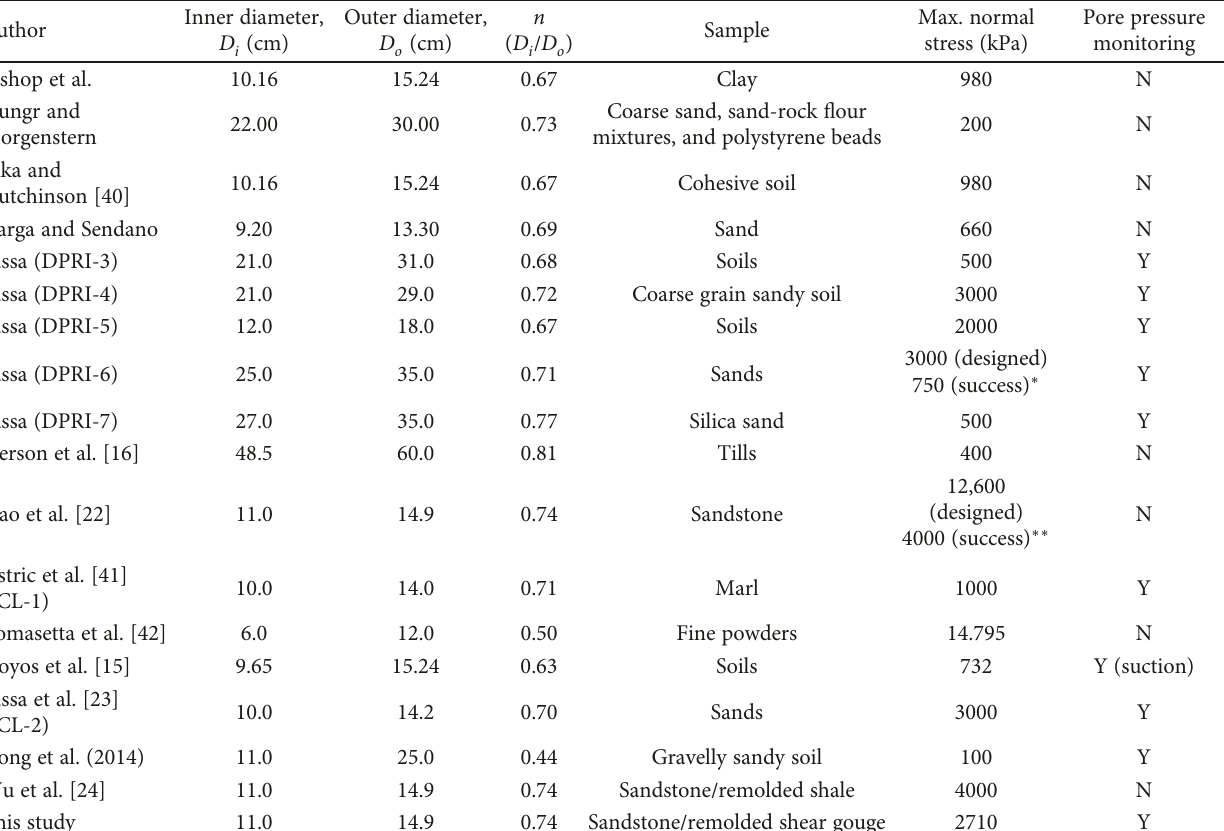
Table 1: The sample size of ring shear test (modi fi ed by